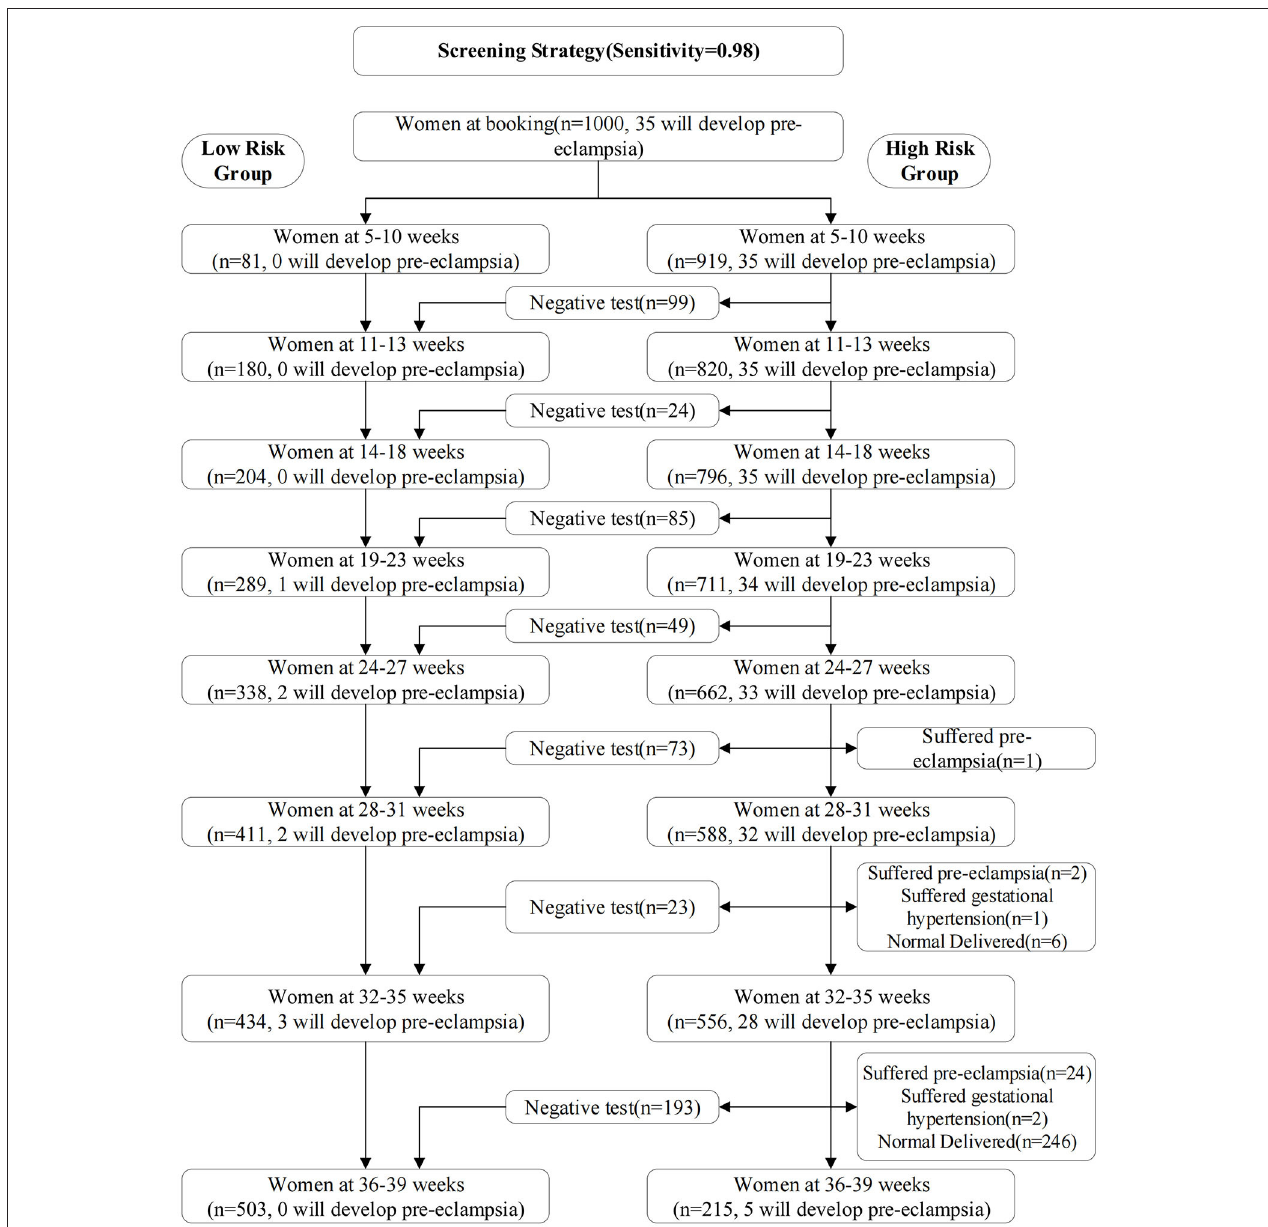
FIGURE 2 | Screening results of the validation set using the optimal prediction models with the sensitivity of 0.98. From 5–10 weeks of gestation, 1000 women participated in prenatal examination.